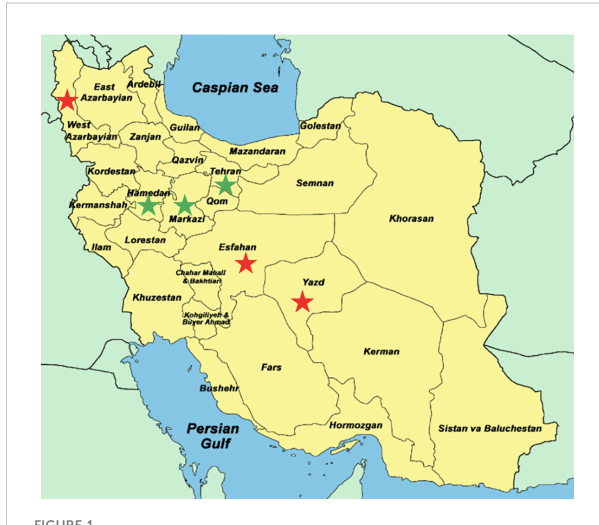
FIGURE 1 Map of Iran showing provinces where alfalfa plants with wilting symptoms were collected for fungus isolation. The green stars show the provinces where fungal isolates were con fi rmed by PCR to be V. alfalfae , the red stars show provinces where the fungal isolates were not con fi rmed as V. alfalfae . Map adapted from Pes ̌ ic ́ et al.